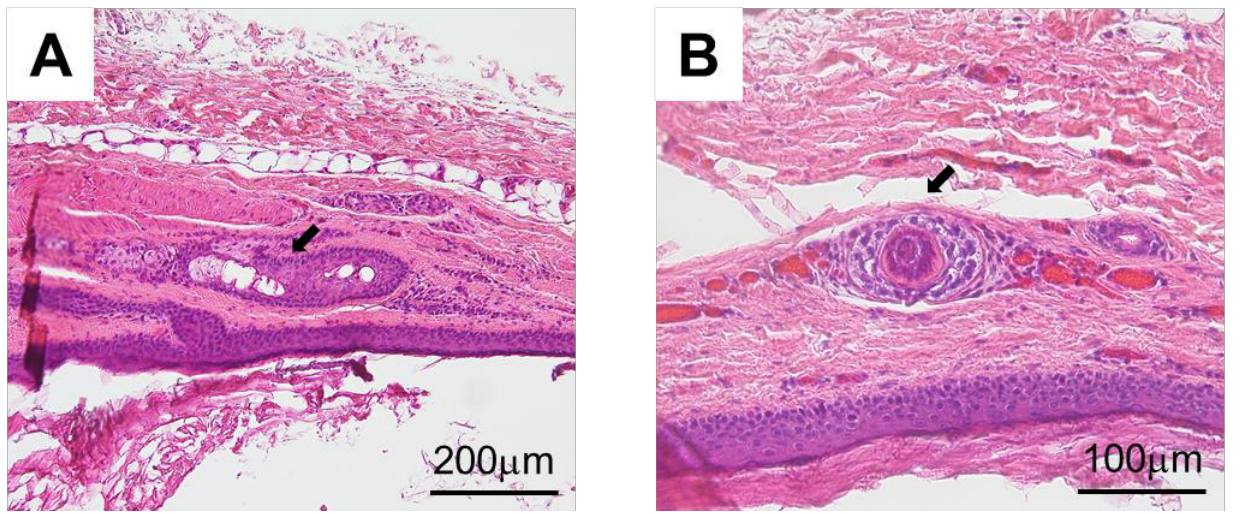
Figure 5. Histopathological examination images (hematoxylin-eosin staining). ( A ) Sebaceous gland (arrow). ( B ) Hair follicle (arrow).